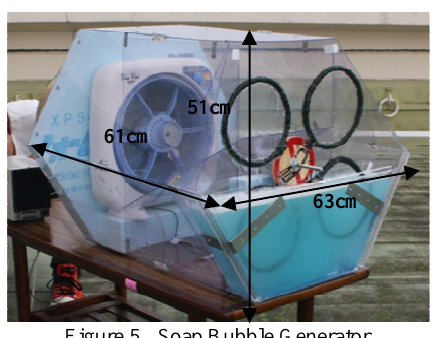
Figure 5. Soap Bubble